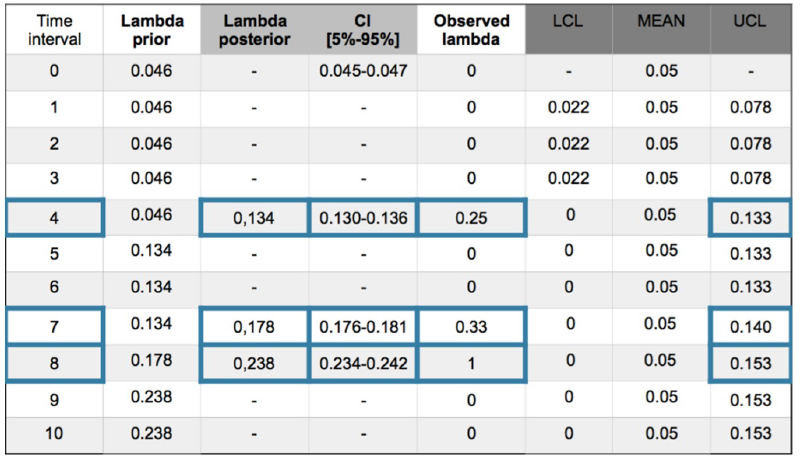
Figure 19. Weibull–gamma model. Recurrent with mean prior method. Evolution of collected (ic’s) and safety barrier fails in 10 intervals. Confidence interval (CI) [5%–95%]. Out of limits framed blue.